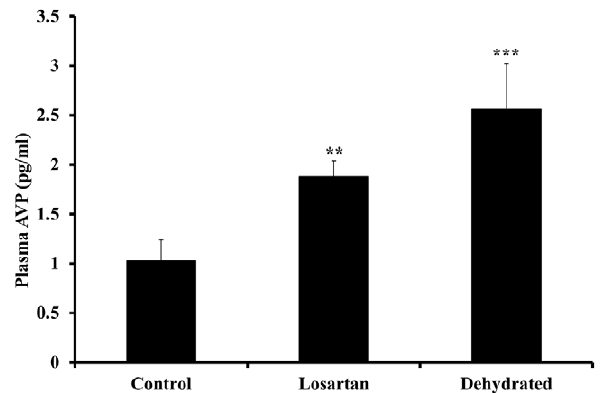
Figure 1. Plasma renin activity in non-dehydrated (‘‘control’’, n=6), Losartan treated (n=6), and dehydrated camels (n=18) on day 20 of dehydration. Data are shown as mean 6 SEM. Significant difference from control is denoted by *p , 0.05, **p , 0.01.